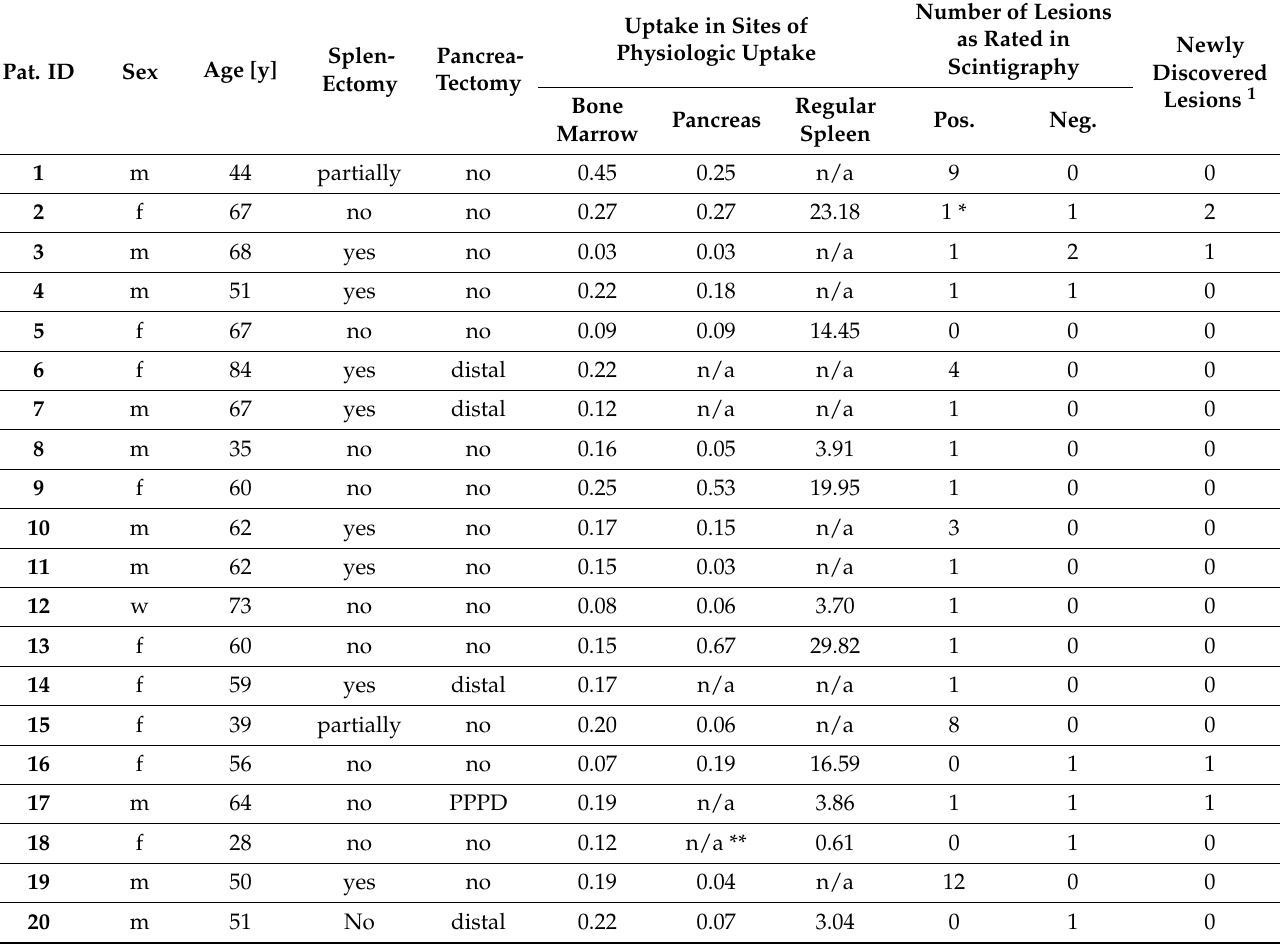
Table 1. Patient characteristics and uptake characteristics. Uptake values are referenced to liver uptake. 1 If information not available, lesions were considered as previously known (“0”). Pos. = positive. Neg. = negative. * = one additional lesion excluded due to spill-in from the adjacent spleen. ** = excluded due to exocrine pancreatic insufficiency secondary to cystic fibrosis. M = male. F = female. PPPD = pylorus-preserving pancreaticoduodenectomy. n/a = not